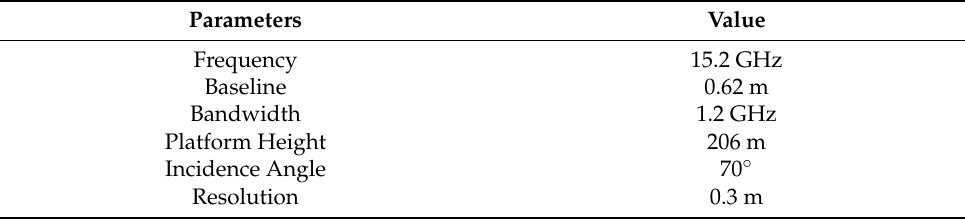
Table 1. Parameters of The PolInSAR System.